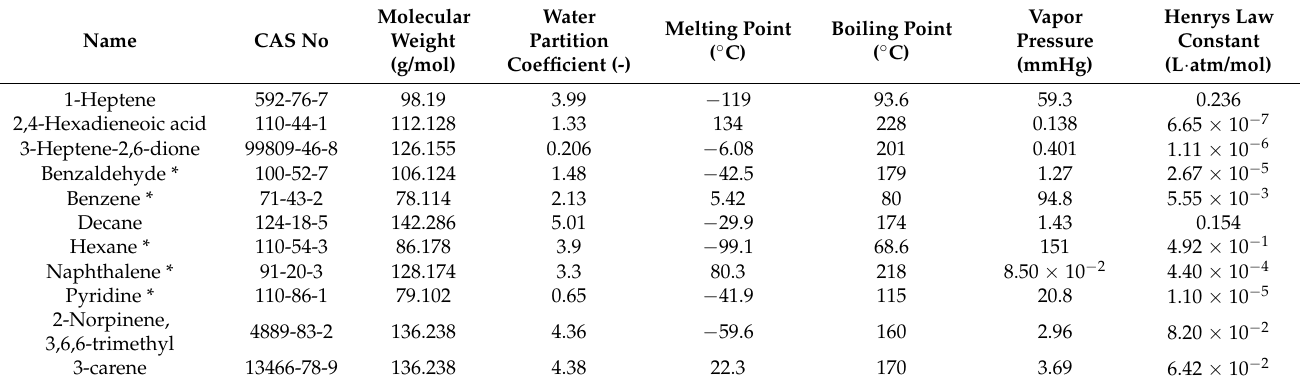
Table A1. Chemical properties of identified chemicals in wood and concrete. The table includes name,